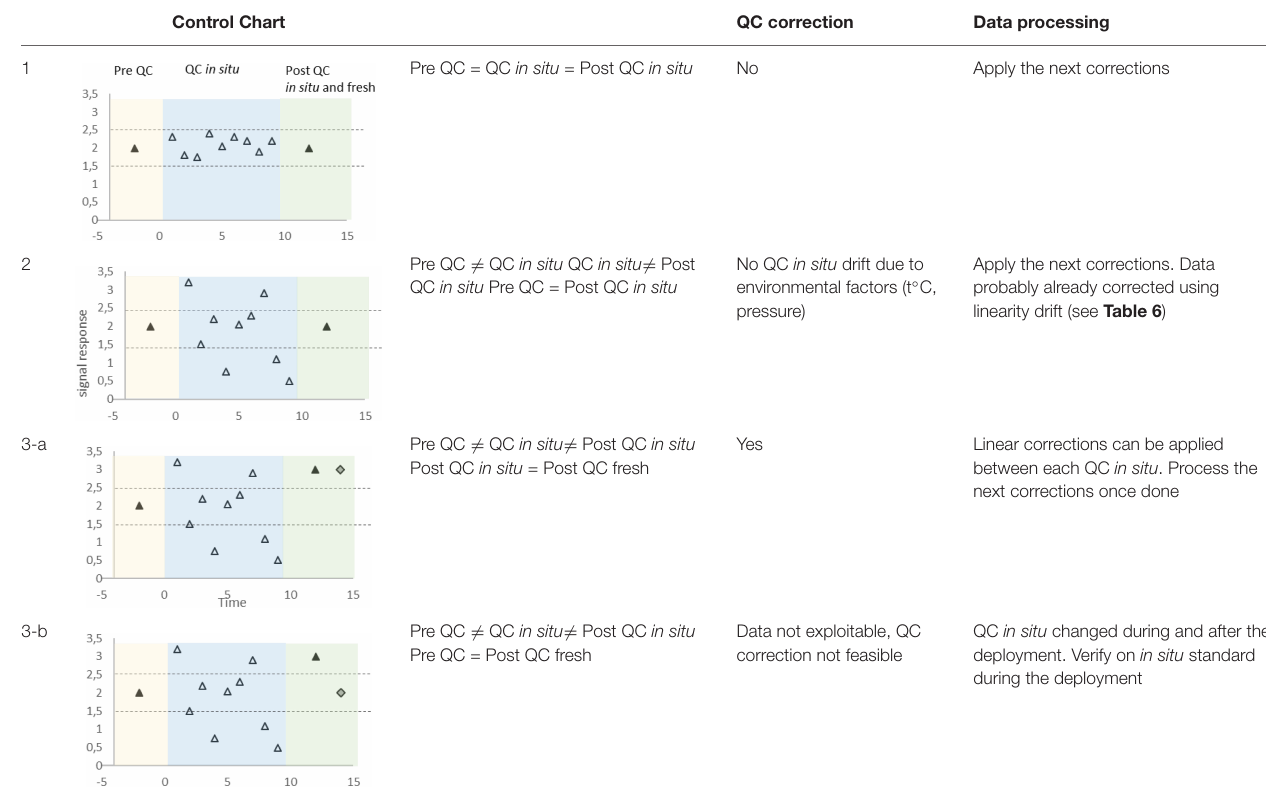
TABLE 7 | Various scenarios and associated corrections (yellow and green areas correspond to tests performed in the laboratory before and after deployment, blue areas are linked to in situ deployment, black triangles stand for analysis of QC before deployment and after deployment (same QC as in situ ) in the laboratory, white triangles for in situ QC during deployment, and gray diamonds for freshly prepared QC analyzed after sensor